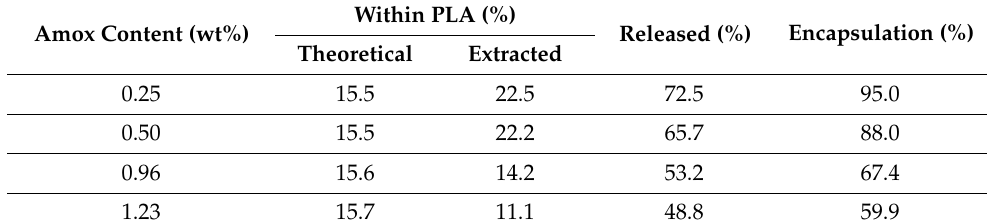
Table 3. Location of amoxicillin in electrospun PLA fiber disks; encapsulation, release, efficiency.